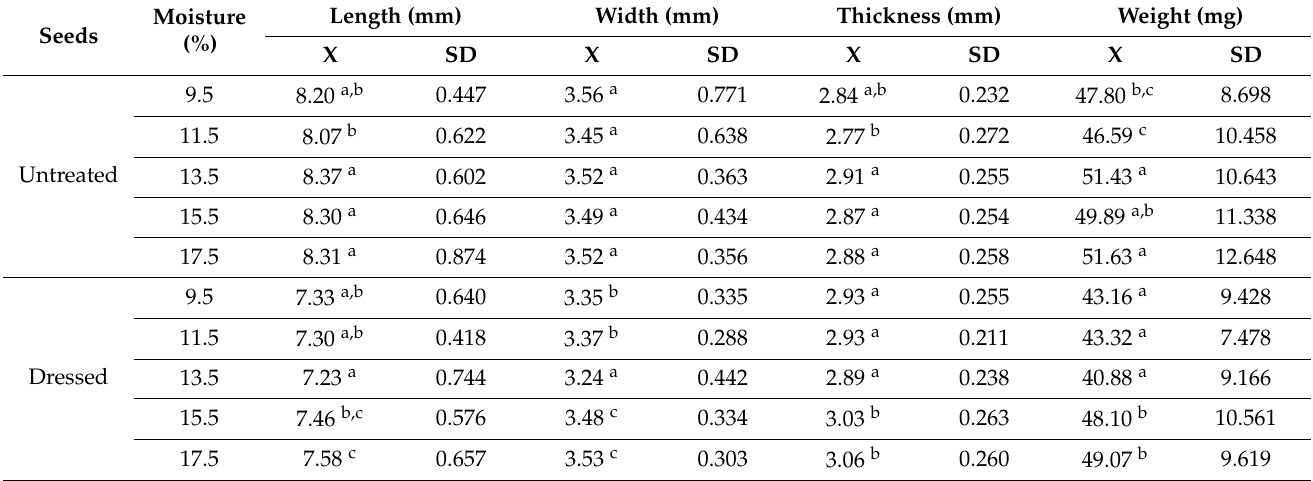
Table 1. The statistical parameters of the physical characteristics of winter triticale seeds.